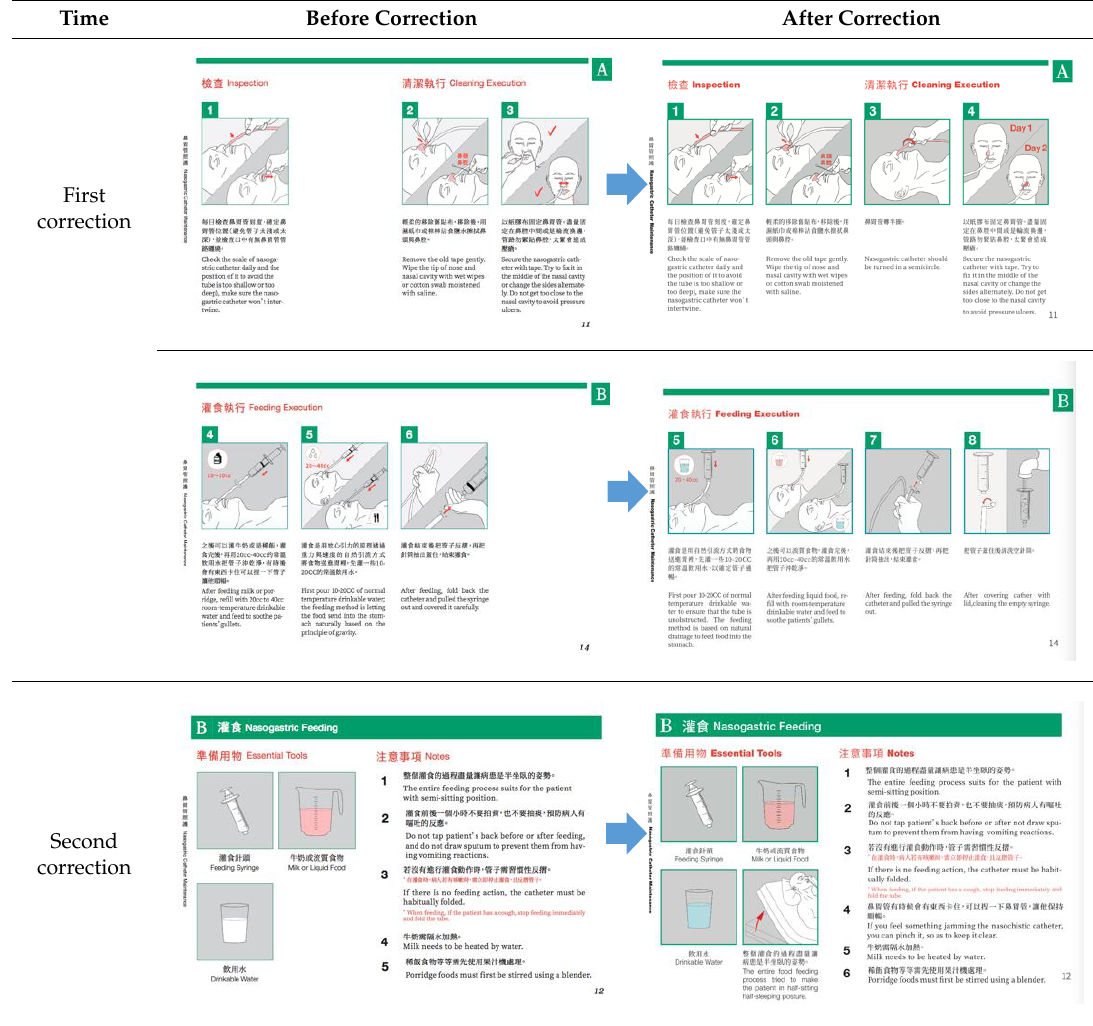
Table 2. Discuss additional procedures and explanations with the nurses.